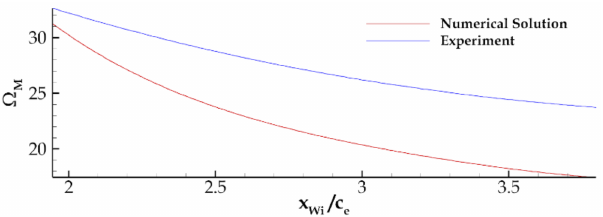
Figure 16. Graph showing the vorticity magnitude of the inboard tip vortex with downstream distance; curves are fitted to a 4th order